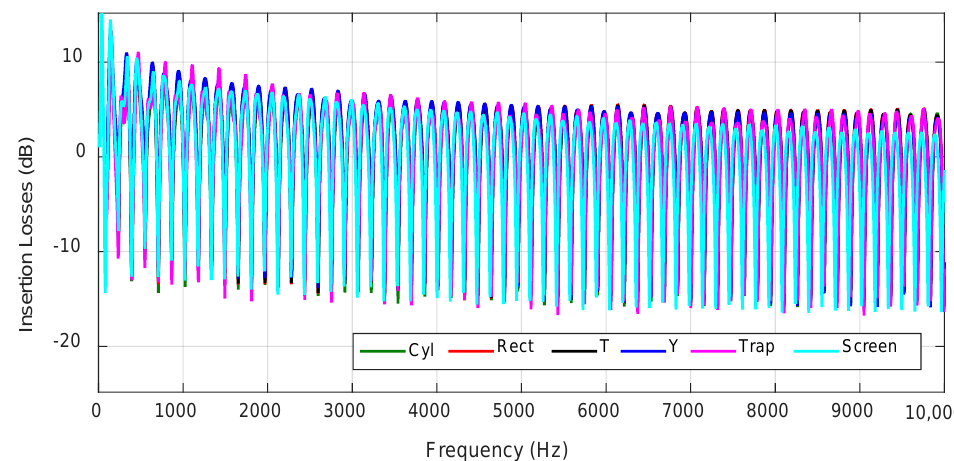
Figure 15. IL in Configuration 4 ‘Ambulance–Balcony’ for single caps and a single screen barrier as a reference.